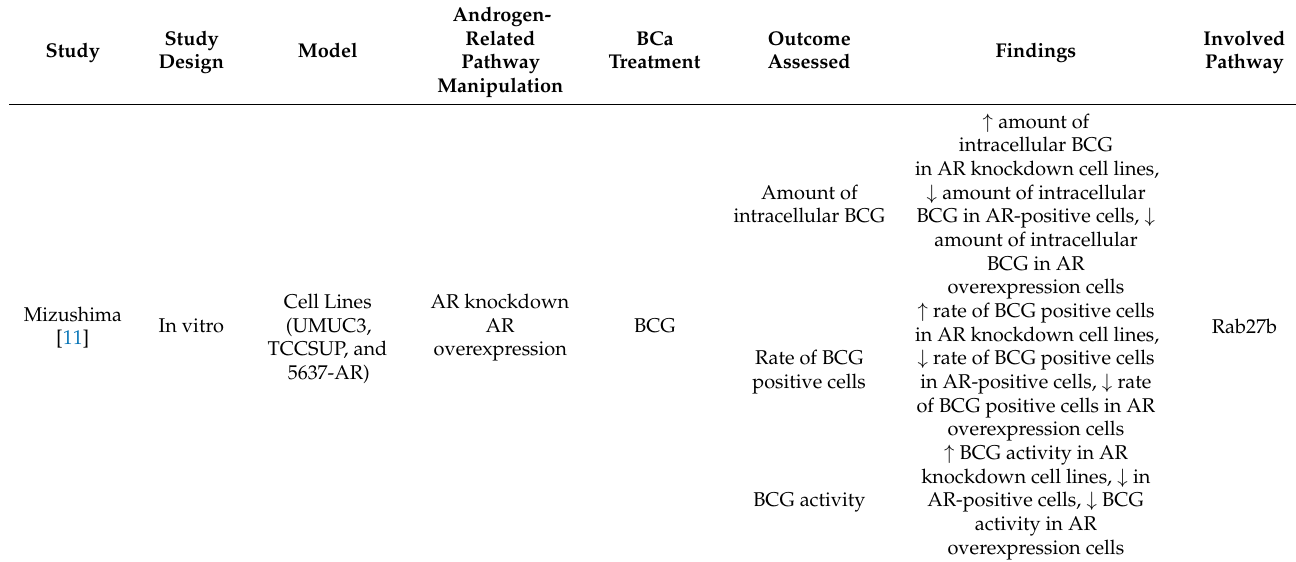
Table 1. Summary of preclinical